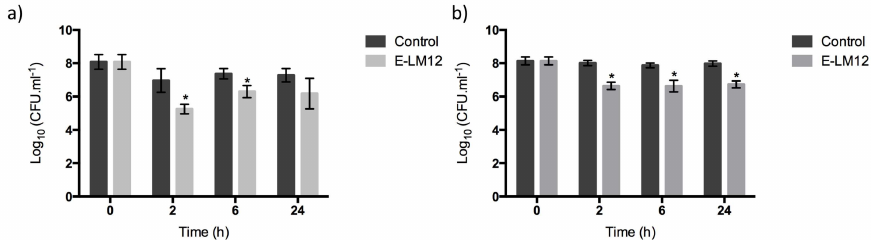
Figure 4. Endolysin E-LM12 activity against S. aureus biofilms, using 8 µ M ( a ) intact biofilms; ( b ) scraped biofilms. Data was assessed by CFU counting, and the values represent the mean (plus or minus) of three independent experiments performed in duplicate. Statistical differences ( p < 0.01) between the control biofilms and the LM12-treated biofilms (*) were determined by two-way repeated-measures analysis of variance (ANOVA) with a Sidak